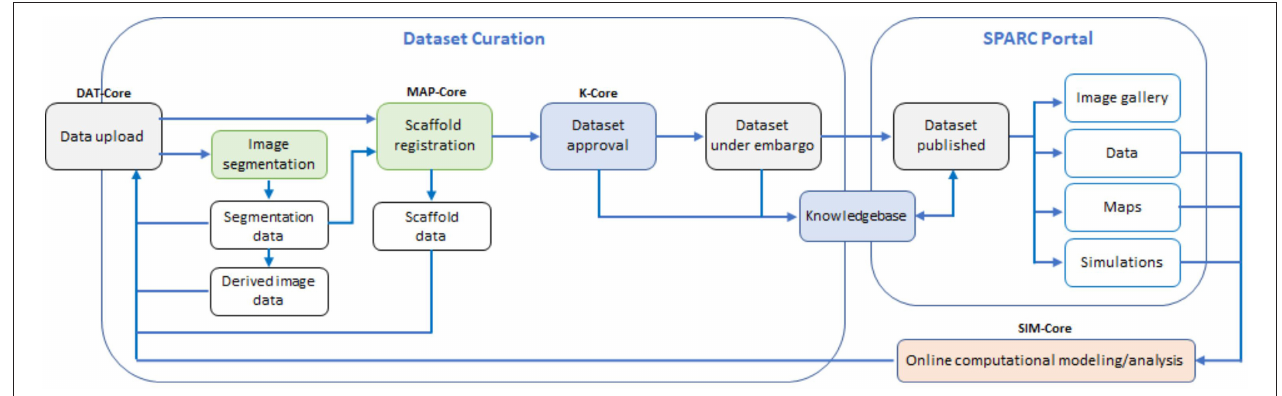
FIGURE 1 | The data workflow: experimental data and mathematical models created by the SPARC community are uploaded to a data repository managed by DAT-Core, along with metadata that is verified by K-Core and used to create a semantic knowledge base for the ANS community. Image segmentation and other data processing steps, including mapping data and models into appropriate anatomical locations using common coordinate systems, is undertaken by MAP-Core. The simulation environment for using the data and models to understand ANS function, and to assist in the development of neuromodulation therapies and devices that modulate that function, is provided by SIM-Core. All cores contribute to the https://sparc.science portal that provides a resource for the ANS biomedical science and bioengineering communities, and for the manufacturers of neuromodulation